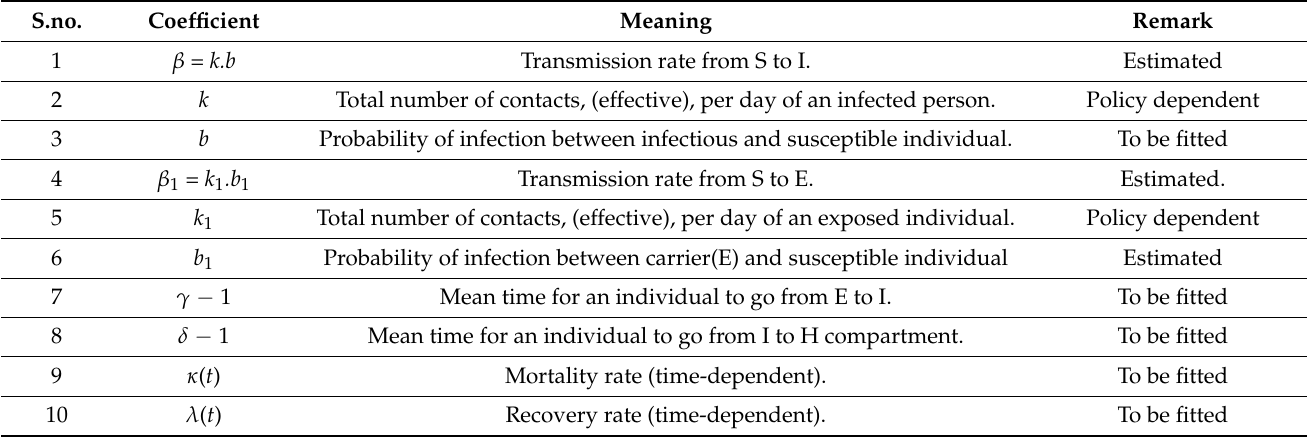
Table 3. The different parameters of the proposed model described by